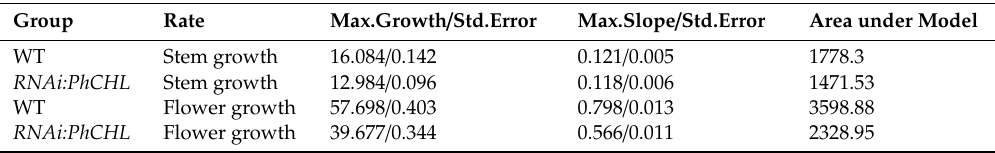
Table 2. Growth rate of petunia stems and flowers. Maximal growth is expressed in mm. Stems grew from day 0 and total growth refers to size achieved after 5 days and 16 h taking as reference the stem at time zero. Maximum growth for flowers refers to the same period but comprises the overall floral size. The maximum slope depicts growth rate while the area under the model (integral) gives an estimation of the overall di ff erence in accumulated